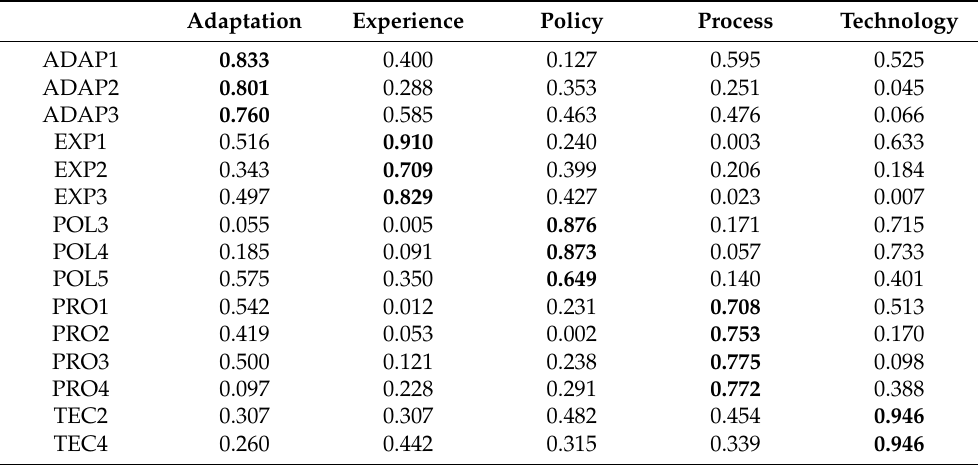
Table 7. Cross-factorial loads of the indicators of each latent